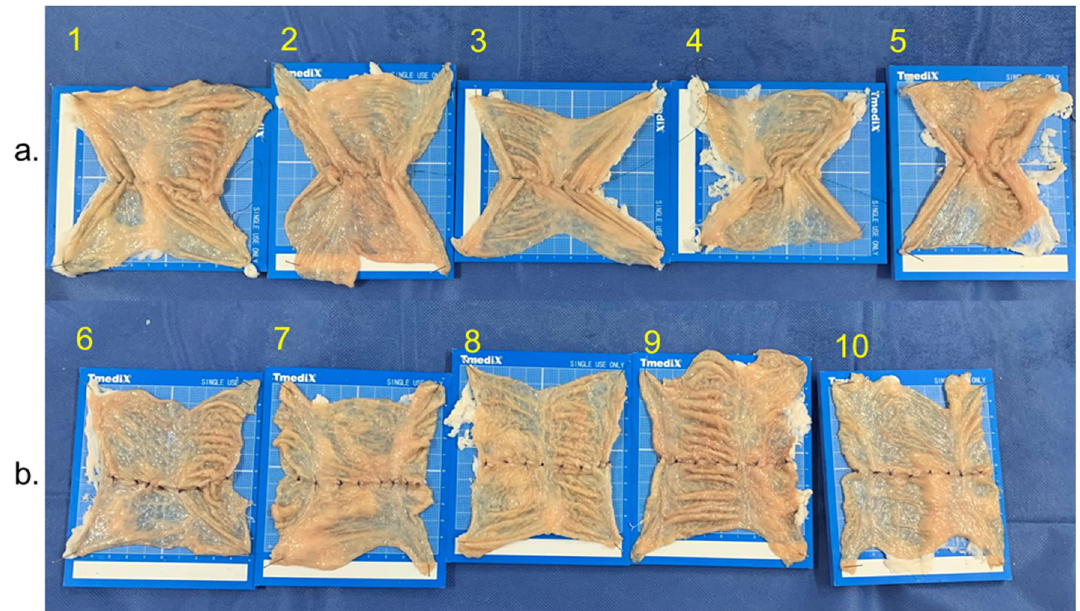
Figure 5. Flat porcine colon models which sutured manually with continuous suturing method and nodule- suturing method. The flat colon models were manually sutured in line by using two types of suturing